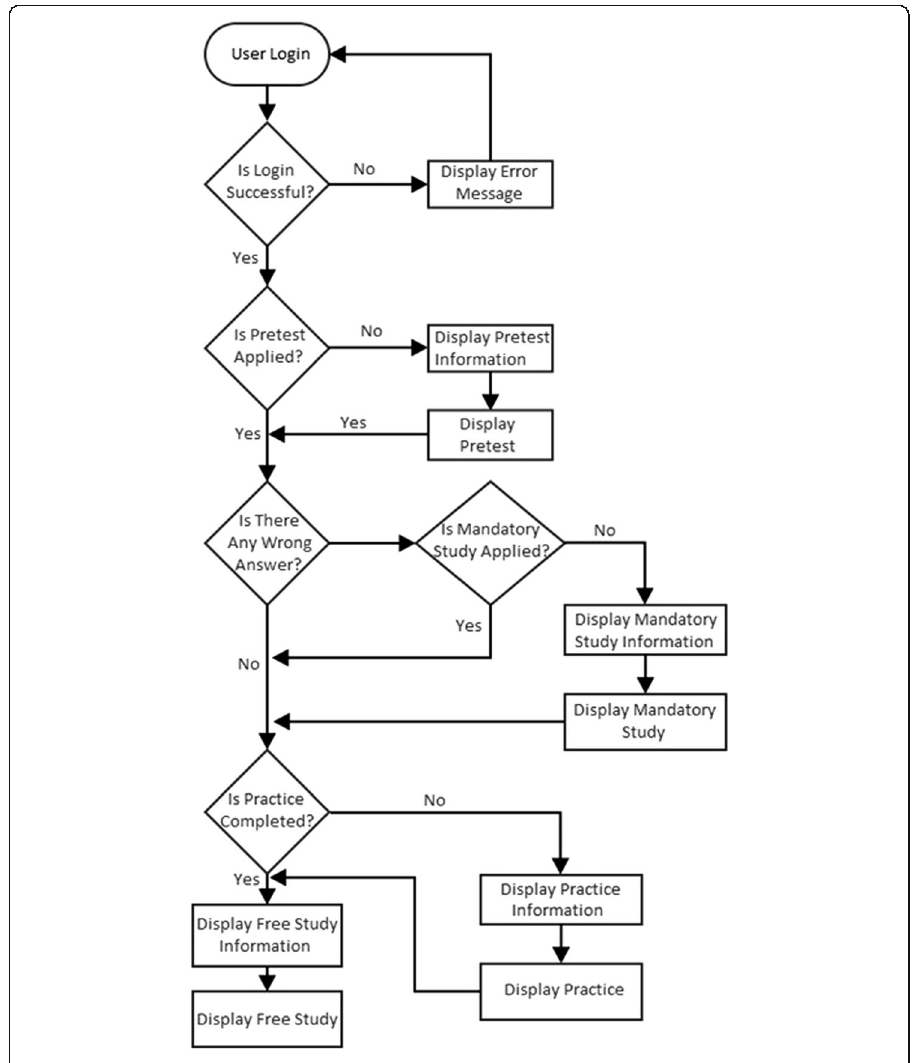
Fig. 10 Whole navigation process of learner in OBCSS